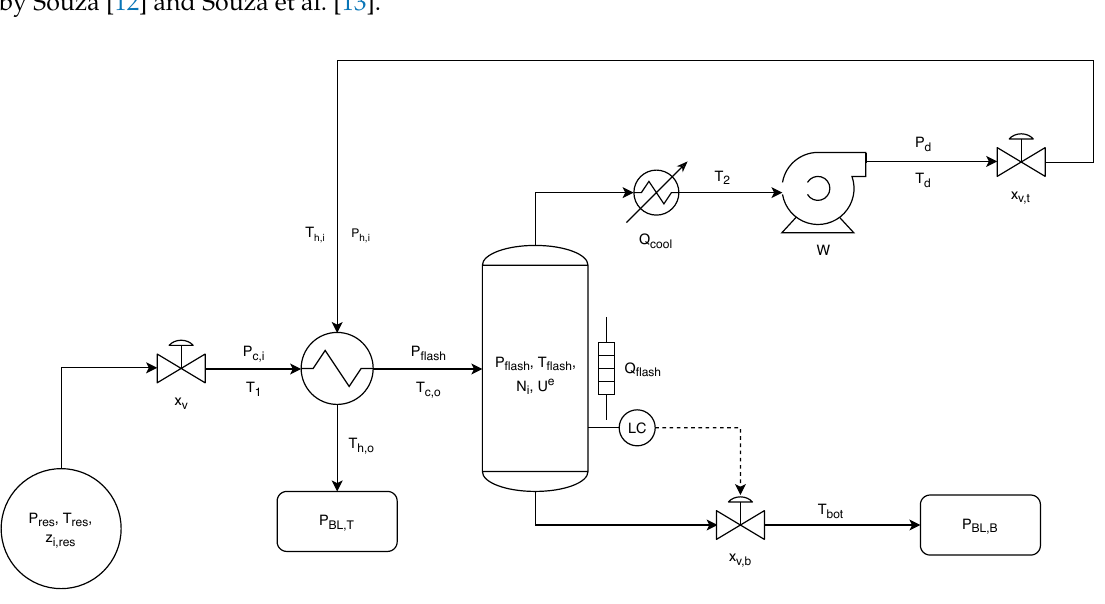
Figure 1. Process diagram, emphasizing correspondent variables